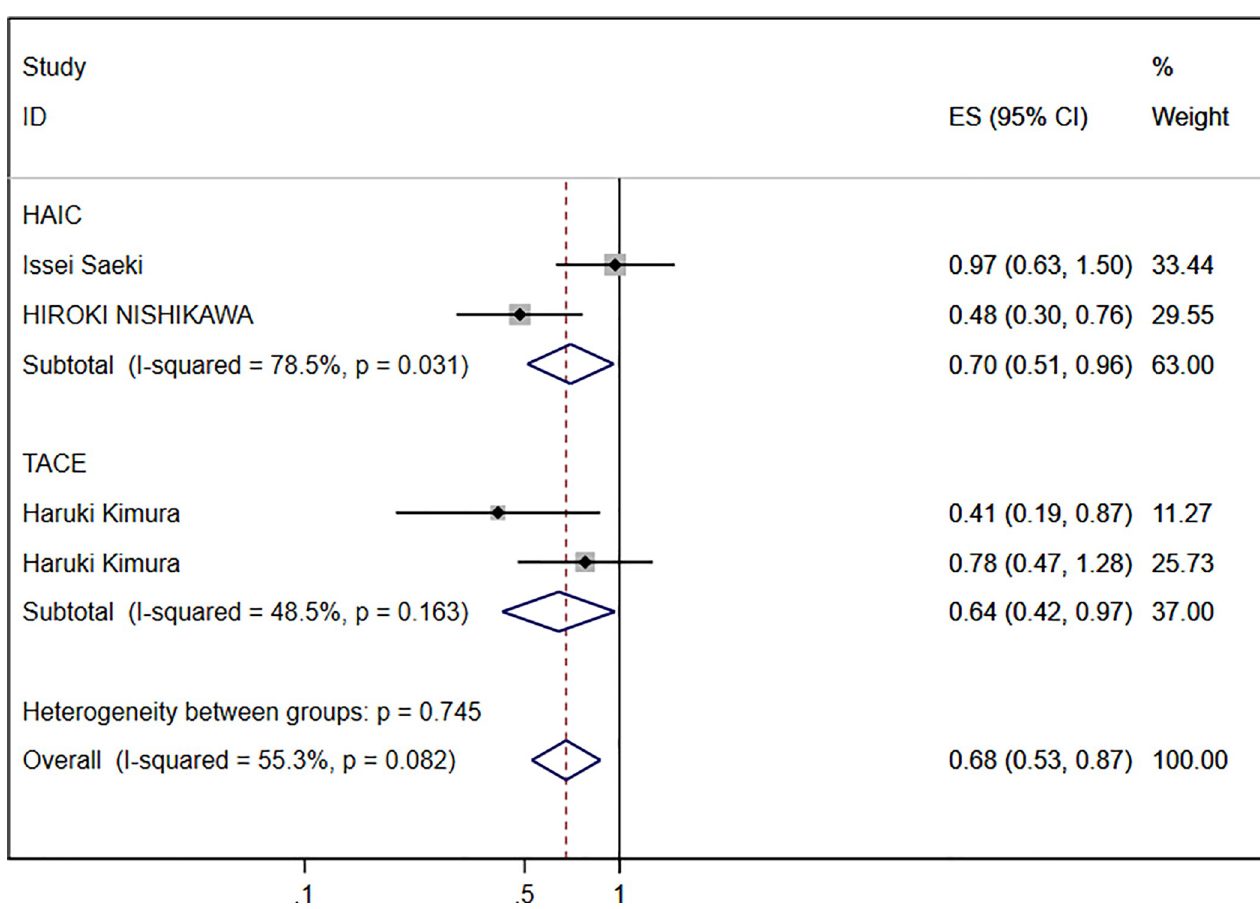
Fig 3. Subgroup analyses of three studies with HR of DCP baseline for